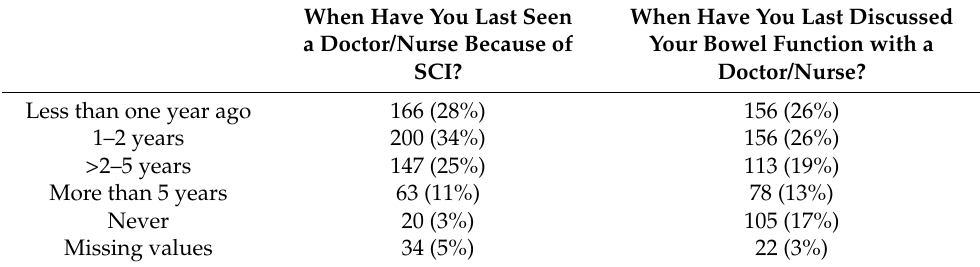
Table 1. The respondent’s contact to the healthcare system.